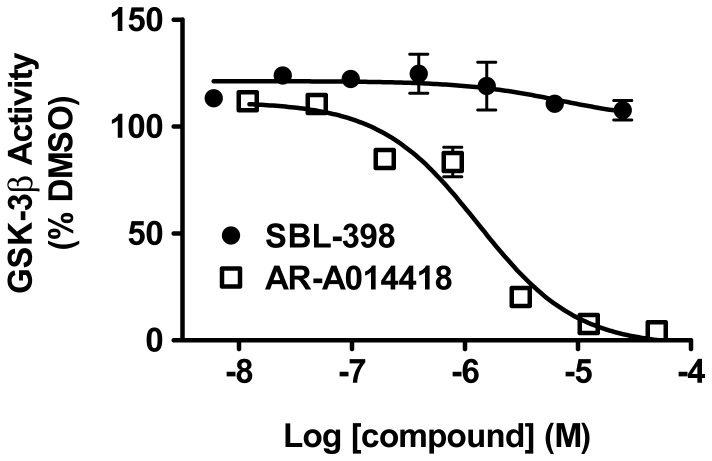
Lack of inhibition of human GSK-3β by SBL-398.Enzymatic activity of purified human GSK-3β, assayed by in vitro phosphorylation of a peptide substrate (see Methods), was not inhibited by concentrations of SBL-398 that approached its aqueous solubility limit. Complete inhibition was achieved with AR-A014418, a commercially available GSK-3β inhibitor. Data points are averages of duplicate samples; apparently absent error bars are in fact obscured by the data symbols.